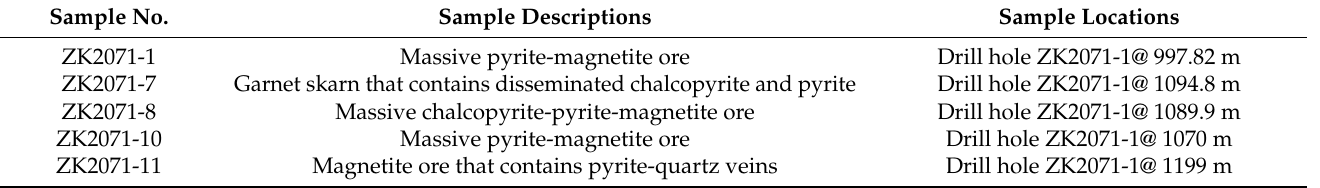
Table 2. Sampling locations of pyrite separates selected for Re-Os isochron dating, collected from the Fe-Cu ore body. Sample No.